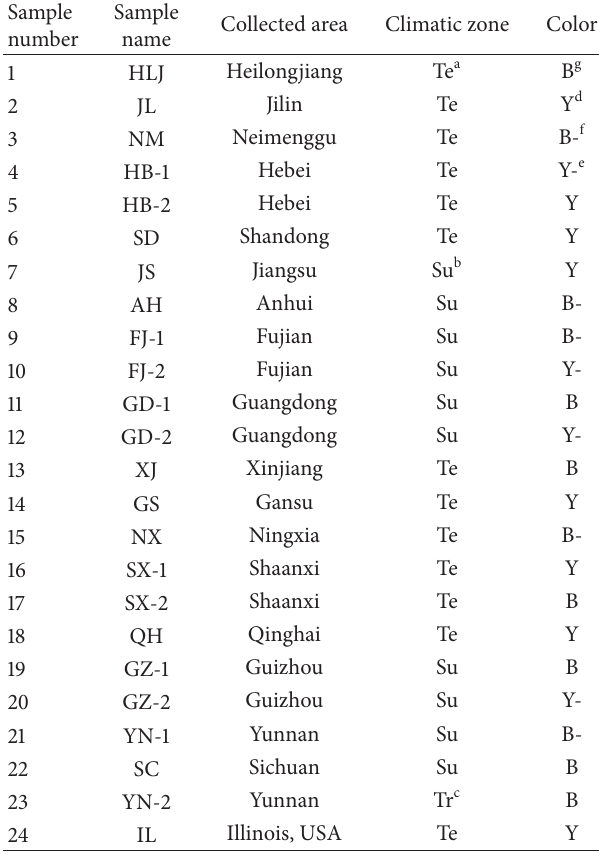
Table 1: Characteristics of the propolis